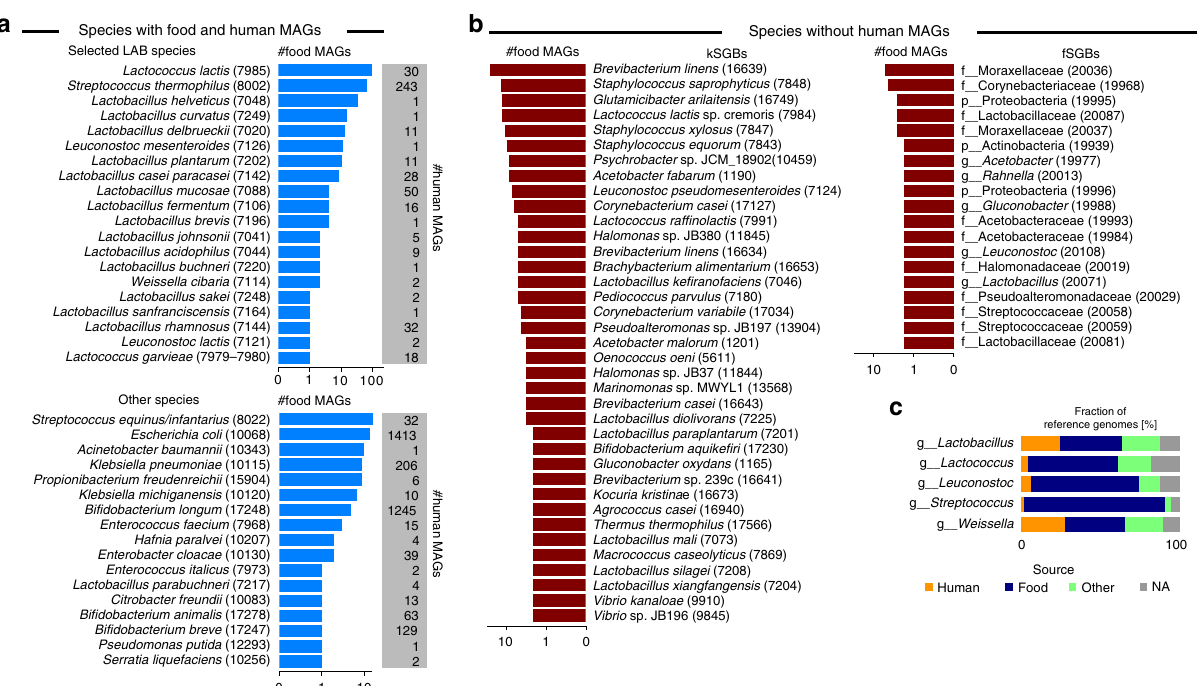
Fig. 2 Microbial genomes reconstructed from food metagenomes. a Most prevalent species-level genome bins (SGBs) in 666 MAGs reconstructed from 303 food metagenomes and overlapping with human MAGs (i.e., found in at least one of the 154,723 human MAGs). Numbers in parenthesis represent the SGB IDs. b Most prevalent food SGBs not overlapping with human MAGs. kSGBs denote SGBs with at least one reference microbial genome, whereas fSGBs identify newly assembled SGBs from food metagenomes only. X-axes for a and b are in logarithmic scale. c Fraction of reference genomes per source type for the 30 selected LAB species and grouped by genera (the same plot at species-level is reported in Supplementary Fig. 6). Raw data in Supplementary Data 6 and